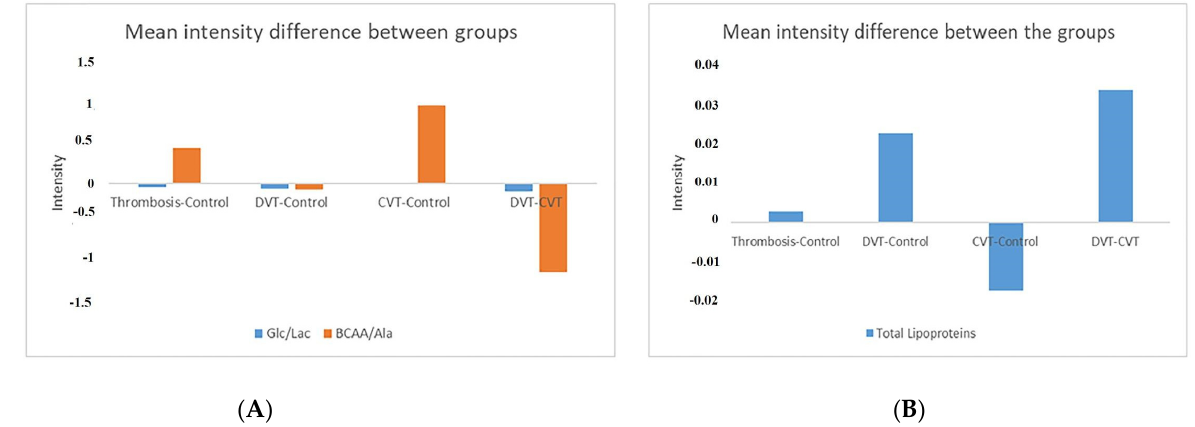
Figure A1. ( A ) Altered ratios of glucose/lactate (Glc/Lac), branched-chain amino acids (BCAAs: leucine, isoleucine, and valine/alanine) (BCAAs/Ala), and ( B ) total of lipoproteins based on mean intensity.